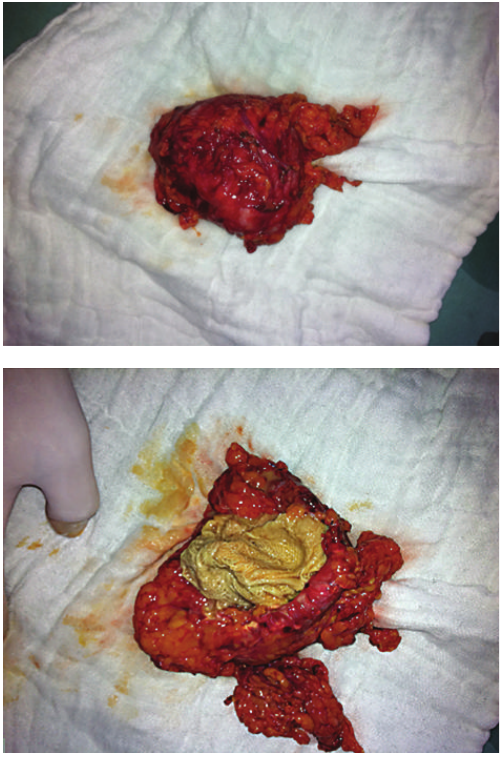
Figure 2: A sponge surrounded by a granulation